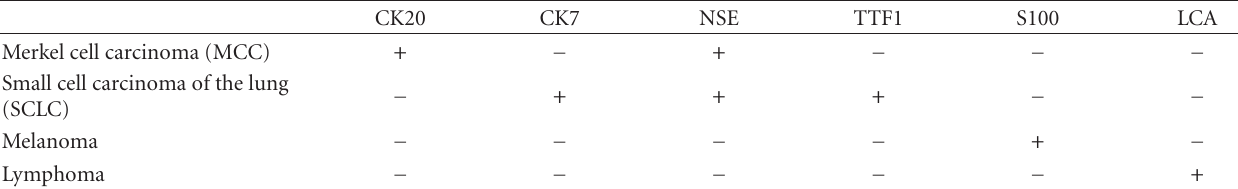
Table 1: Immunohistochemistry of Merkel cell carcinoma (according to Schrama et al. 2011, Becker et al. 2008; [17, 18]). CK20: